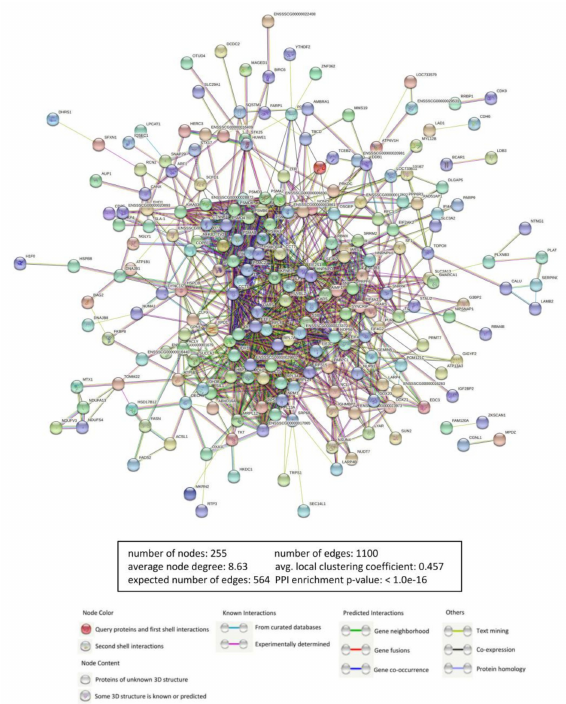
Figure 2. Construction and analysis of the protein–protein interaction (PPI) network using the STRING database. Each edge color indicates a different method of PPI prediction, as indicated below in the figure. The map of ASFV MGF360-9L-interacting proteins further interacting with the other proteins of our data was constructed and plotted using the network analyzer tool, Cytoscape v.3.7.1. The corresponding symbols indicating different protein classes are mentioned in the figure. Proteins are represented as the respective NCBI gene